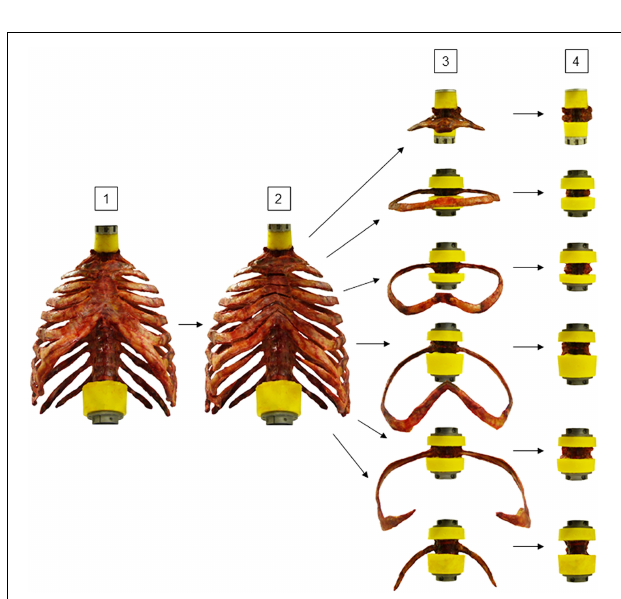
FIGURE 2 | Illustration of experimental design. Eight rib cage specimens were tested stepwise [1] polysegmentally with intact sternum (Poly intact), [2] polysegmentally without intersegmental sternal and cartilaginous rib-to-rib connections (Poly w/o), [3] monosegmentally including ribs and sternal connection (Mono intact), and [4] monosegmentally without ribs (Mono w/o).